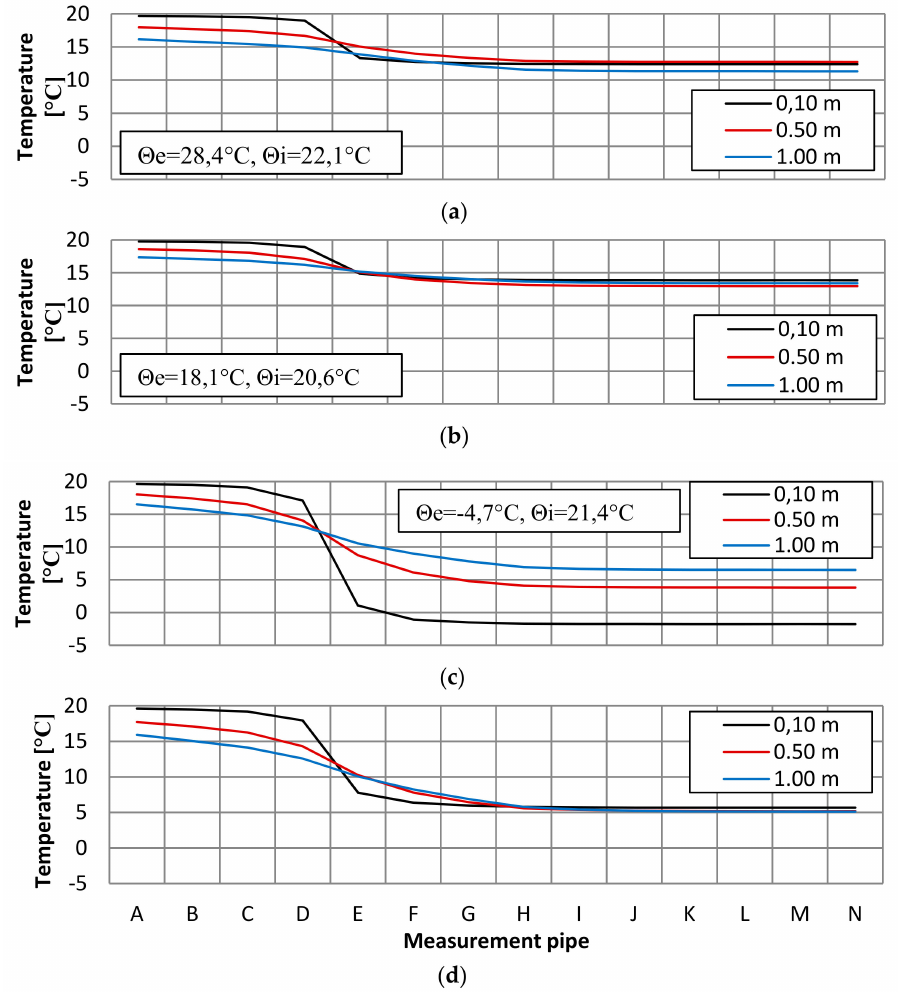
Figure 7. Soil temperature in measurement lines and levels and interior ( Θ i ) and exterior ( Θ e i ) air temperature: ( a ) summer (15 July), ( b ) autumn (15 October), ( c ) winter (15 January), and ( d ) spring (15